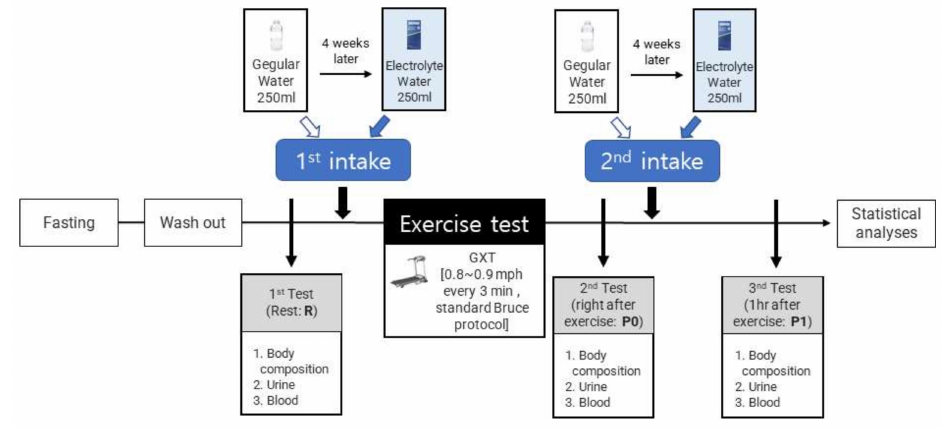
Figure 1. Study design.